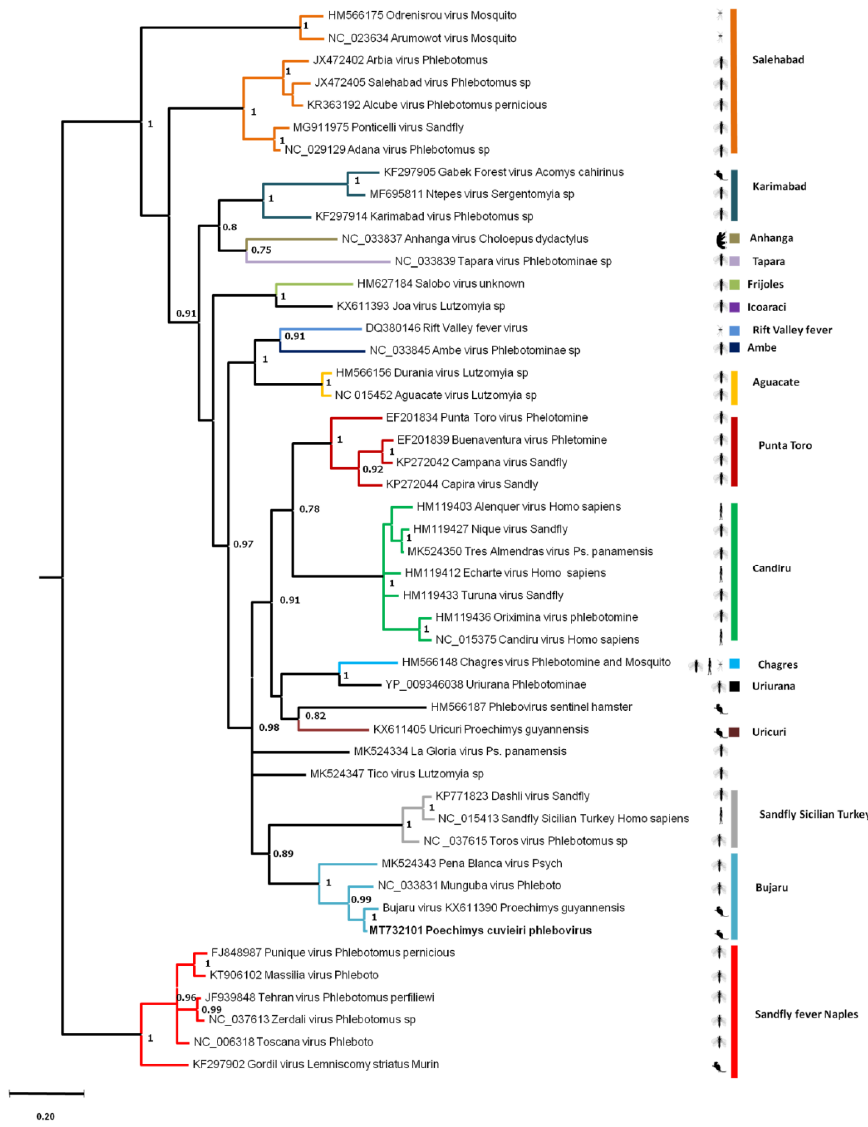
Figure 8. A phylogenetic tree based on one fragment of the nucleocapsid protein (alignment of 537 nucleotides/179 amino acid positions) of each well-known phlebovirus antigenic complex representative. The tree was inferred from amino acid sequences using the Bayesian method with the WAG model. Sequence identifiers include the NCBI accession number and the isolate name. Poste- rior probabilities of the Bayesian analysis (>70%) are shown next to the nodes. The scale bar indicates amino acid substitutions per site. The sequence of P. cuvieri phlebovirus is indicated in red. The species–complexes (established by ICTV or suggested in [81,82]) are indicated with colored bars (if many members are present) and dots (if one member is represented). Names of established species–